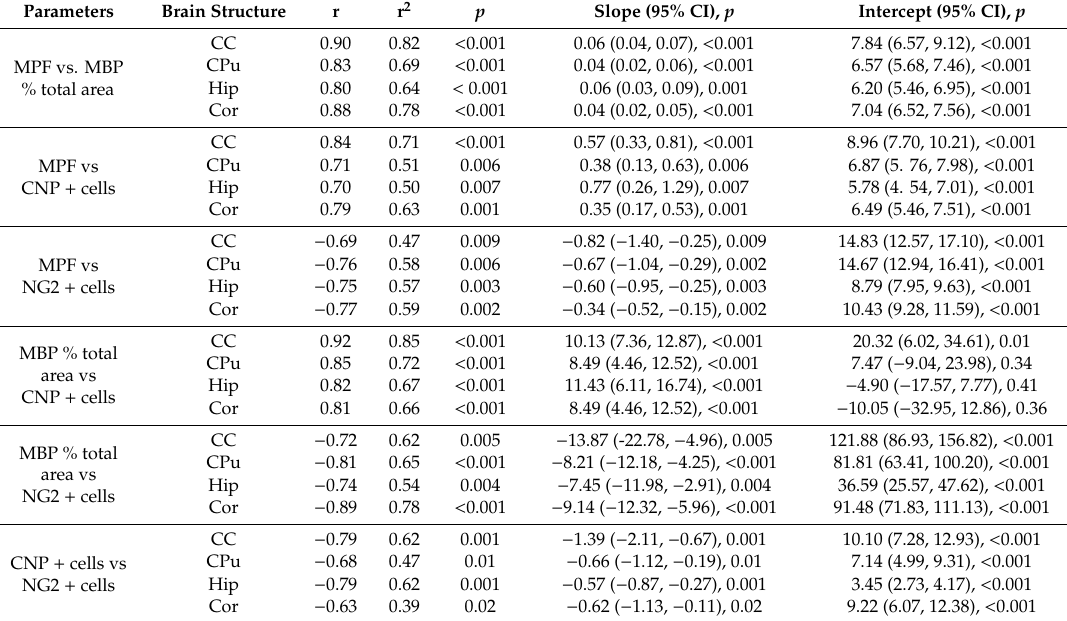
Table 2. Linear regression analysis of associations between MPF, MBP-stained percentage of the total area, CNP-positive cell count, and NG2-positive cell count in the corpus callosum, caudate putamen, hippocampus, and